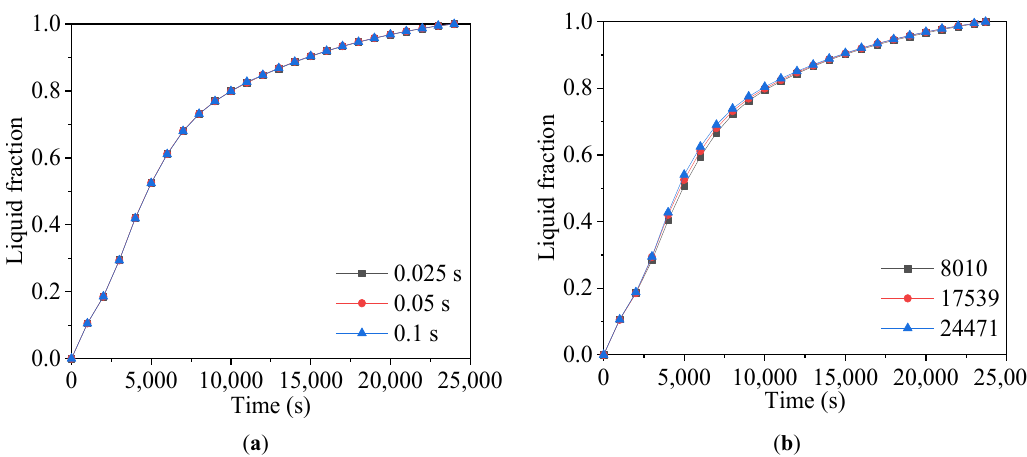
Figure 2. Time-step and mesh-size tests. ( a ) Time step and ( b ) mesh size.